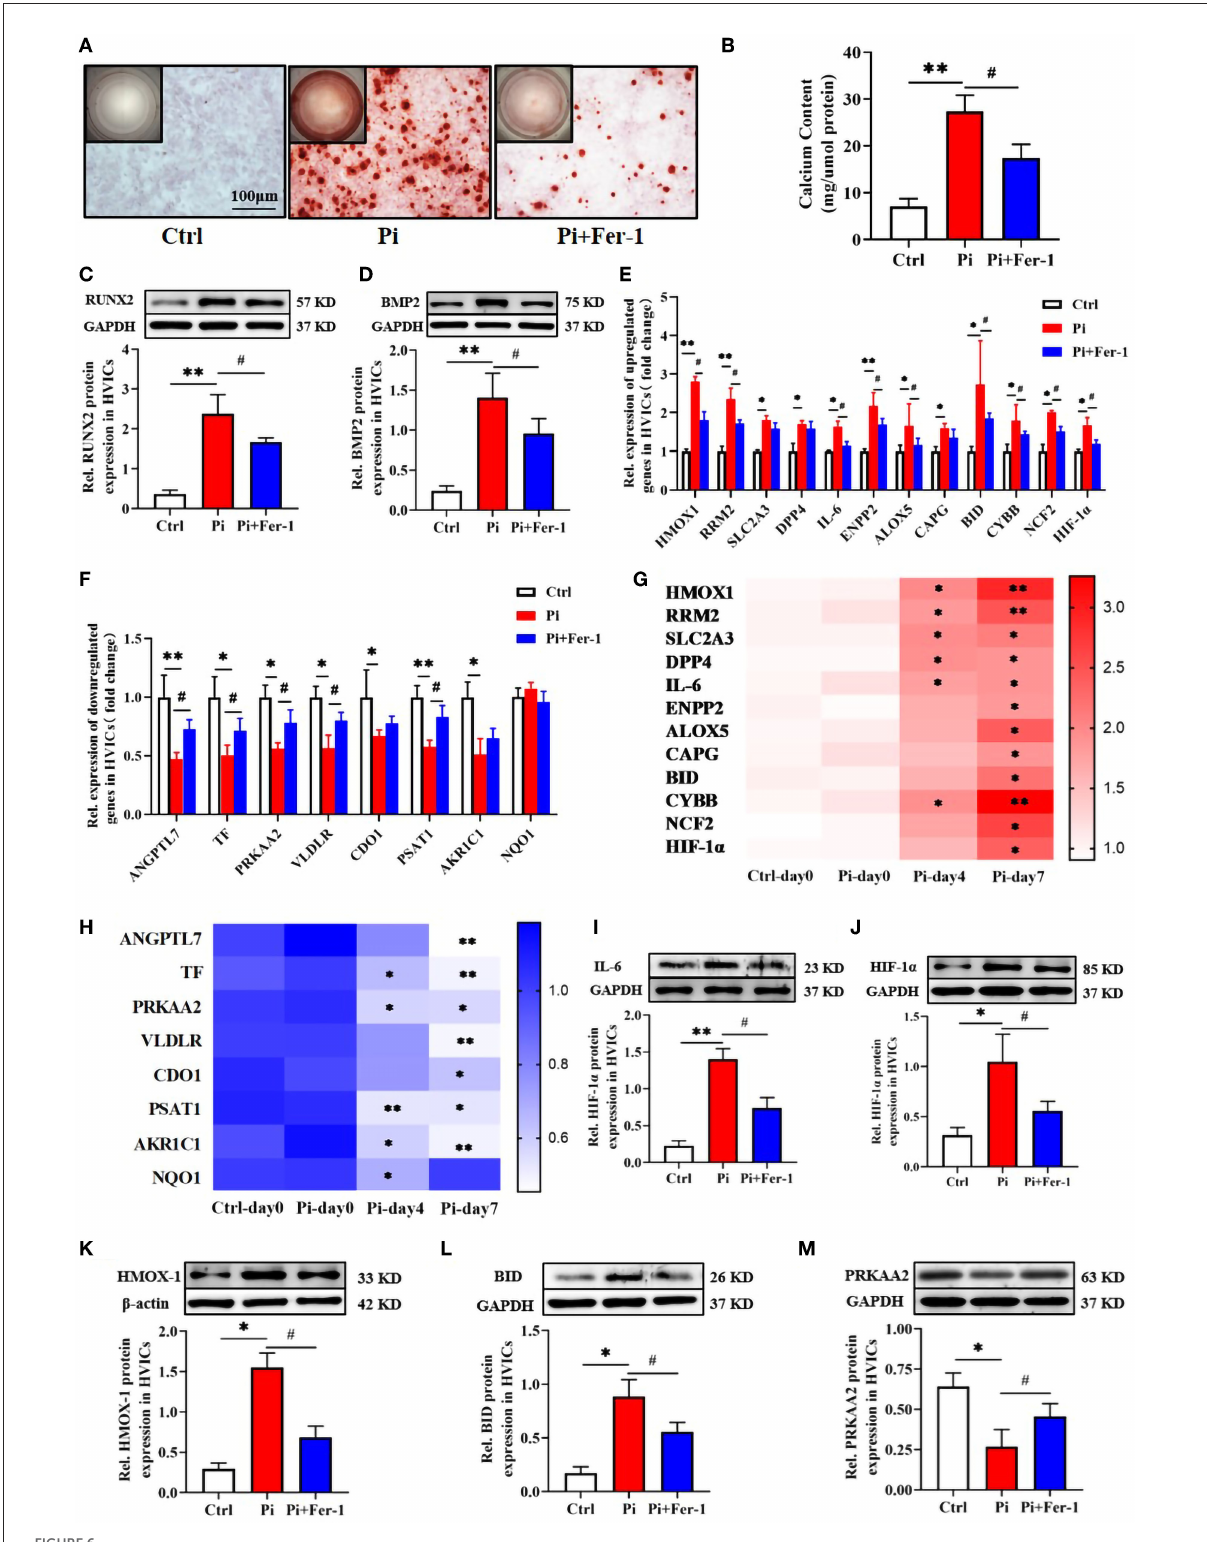
FIGURE6 Validation of the potential biomarker expression in vitro . (A) Calcium deposition in VICs visualized using Alizarin red stain (red signal). Representative macroscopic (top left corner) and microscopic (the rest, scale bar: 100 µ m) findings were shown. (B) Quantification of